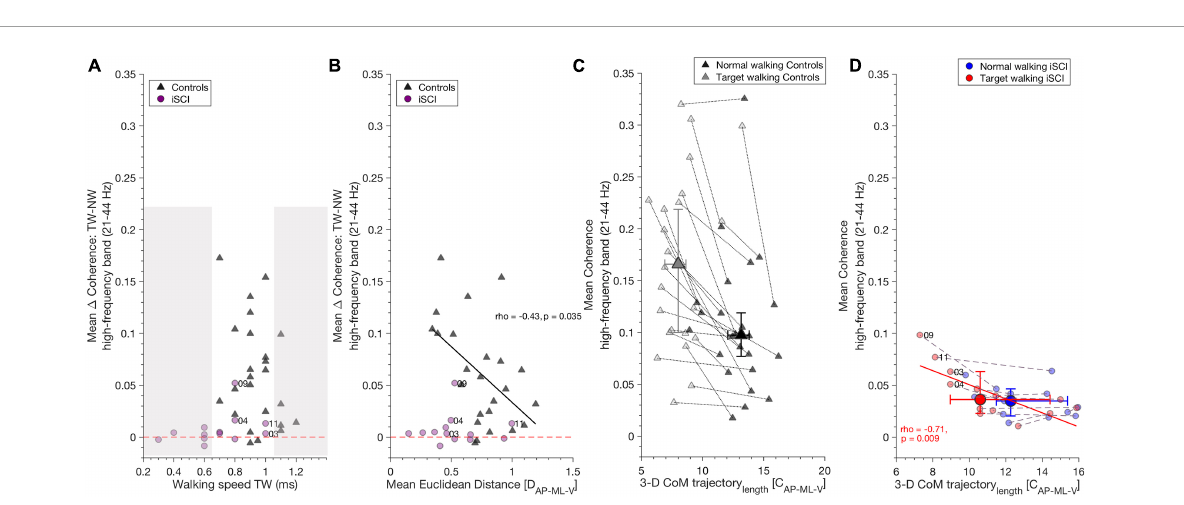
FIGURE4 High-frequency coherence is related to gait parameters. (A) TW speed did not influence increased high-frequency coherence during TW compared to NW, as shown by the TW effect (Target walking – Normal walking): iSCI (purple dots) and controls (dark gray triangles) increased high-frequency band coherence independent of their walking speed in TW. The non-shaded area depicts iSCI and controls with the same walking speeds. Dashed red line indicates the zero value and distinguishes positive and negative TW effects. (B) In controls, increase of high-frequency coherence during TW as shown by TW effect (Target walking – Normal walking) correlated negatively with mean Euclidean distance, whereas in iSCI no correlation was found. Thus, controls who were able to adapt their gait pattern during TW showed decreased TW effect compared to those controls who adapted their gait pattern to a lesser extent. Dashed red line, dots and triangles as in (A) . (C) A reduction of 3-D CoM trajectory length along with an increase in high-frequency coherence is a typical mechanism found during TW in controls but there is no significant relationship between these parameters. (D) However, in individuals with iSCI, 3-D CoM trajectory length during TW negatively correlates with mean TW high-frequency coherence in (red dots). No such relationship was found during NW in individuals with iSCI (blue dots). Gray dotted lines and purple dashed lines connect NW and TW for each control and iSCI, respectively. Dots (individuals with iSCI) and triangles (controls) represent single participants and their ID. Large dots and triangles depict the median and their 95% confidence intervals. iSCI’s ID’s are shown for the skilled or less affected individuals. CoM, center of mass; iSCI, incomplete spinal cord injury; NW, Normal walking; TAp, Tibialis anterior proximal; TAd, Tibialis anterior distal; TW, Target walking. Spearman’s rho and p -values are presented where significant; regression lines and 95% confidence limits are omitted for